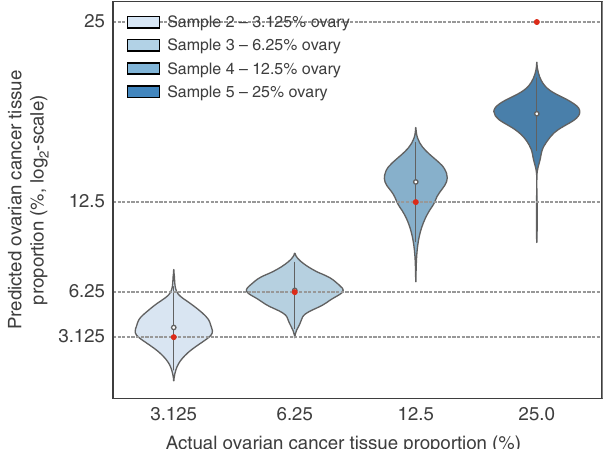
Fig. 6 Proportion of ovarian cancer tissue predicted by a multilayer perceptron regressor. Violin plots indicate the ovarian cancer tissue proportions predicted by a multilayer perceptron regressor model. The expected ovarian cancer tissue proportion for each sample is marked by a red data point. Source data are provided as a Source Data fi